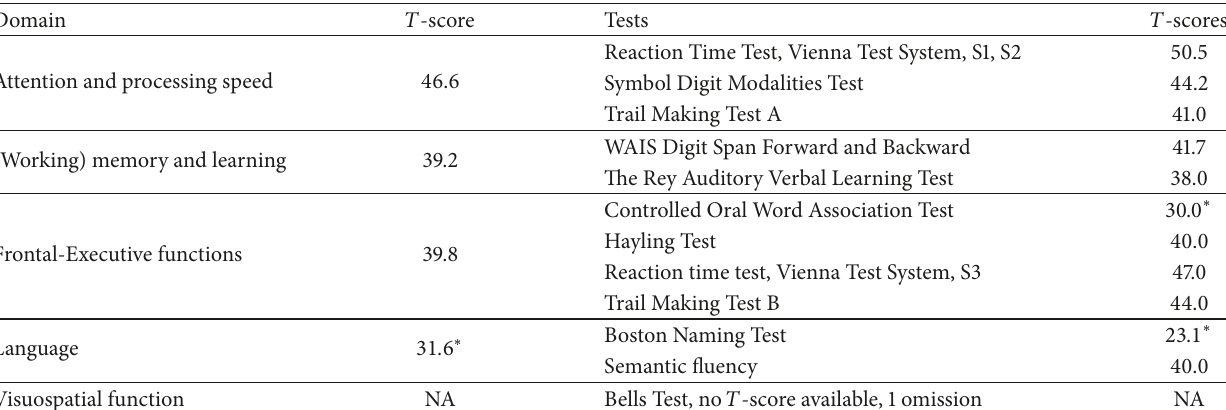
Table 2: Neuropsychological assessment of the